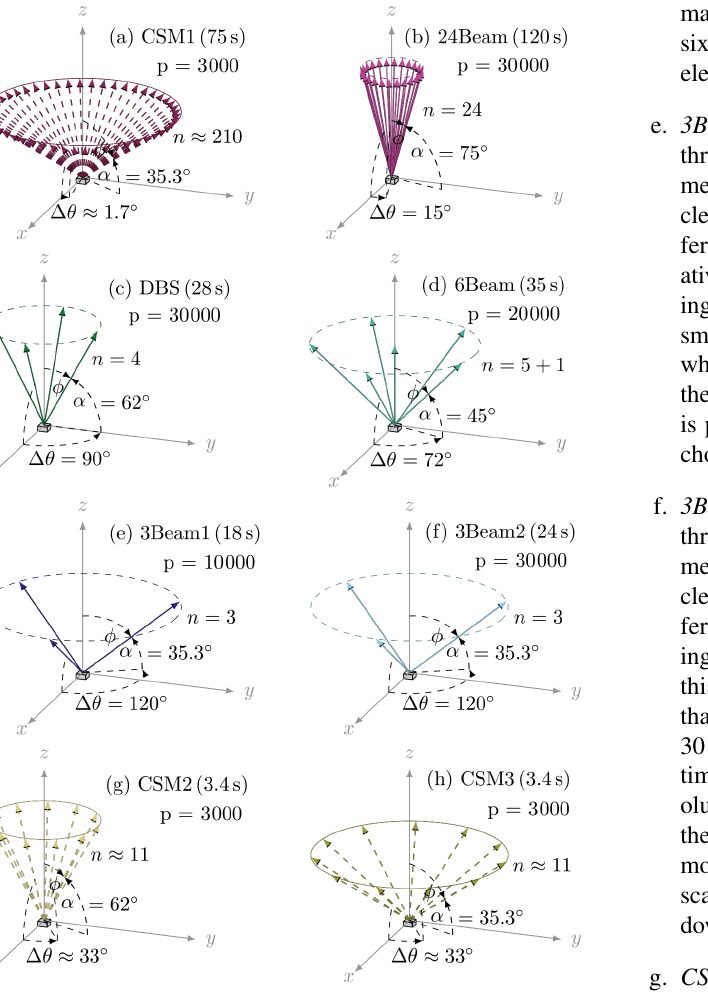
Figure 3. The different tested DWL configurations with corre- sponding averaged cycle time (in parentheses), the total number of averaged pulses per measured Doppler velocity ( p ), their elevation angle ( α ) and azimuth step angle ( (cid:49)θ ), and the number of beams per cycle ( n ; for the continuous modes this is an approximated